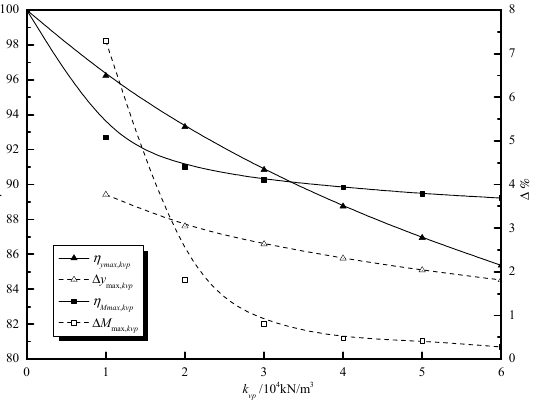
k , η M max, k and ∆ y max, k , ∆ M max,, k along with k vp . . vp vp vp vp